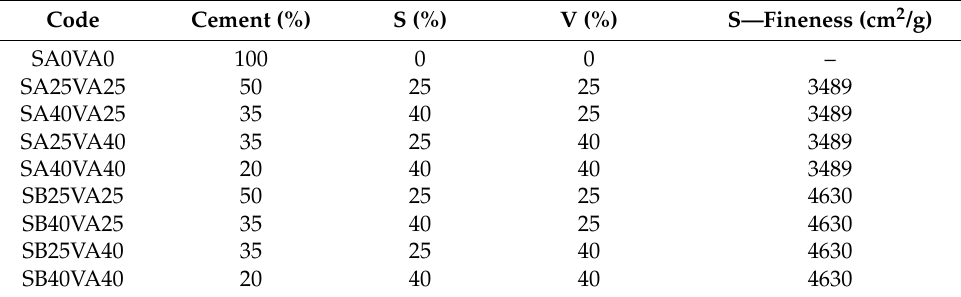
Table 4. Codes and proportions of ternary cements.